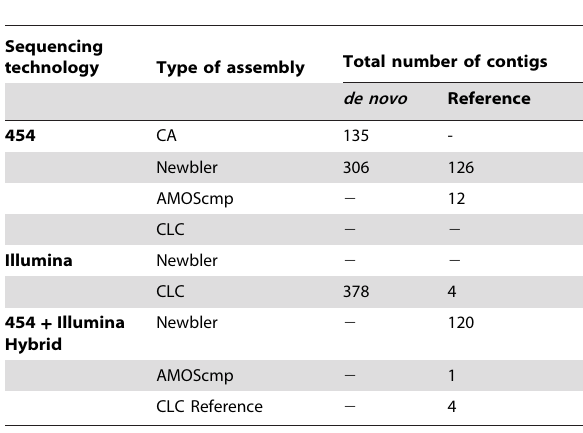
Table 1. Summary of sequencing results for Y. pestis KIM D27 and comparison with